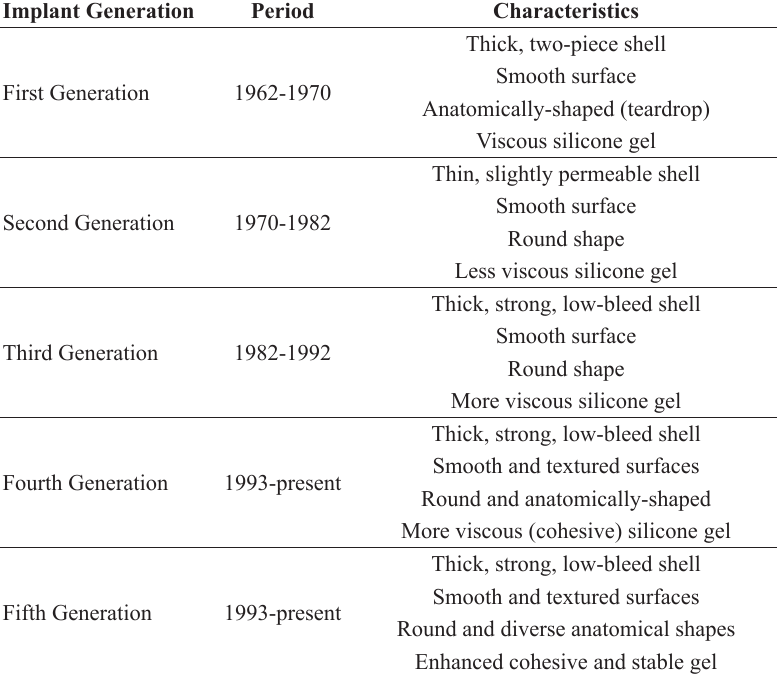
Evolution of silicone gel-filled breast